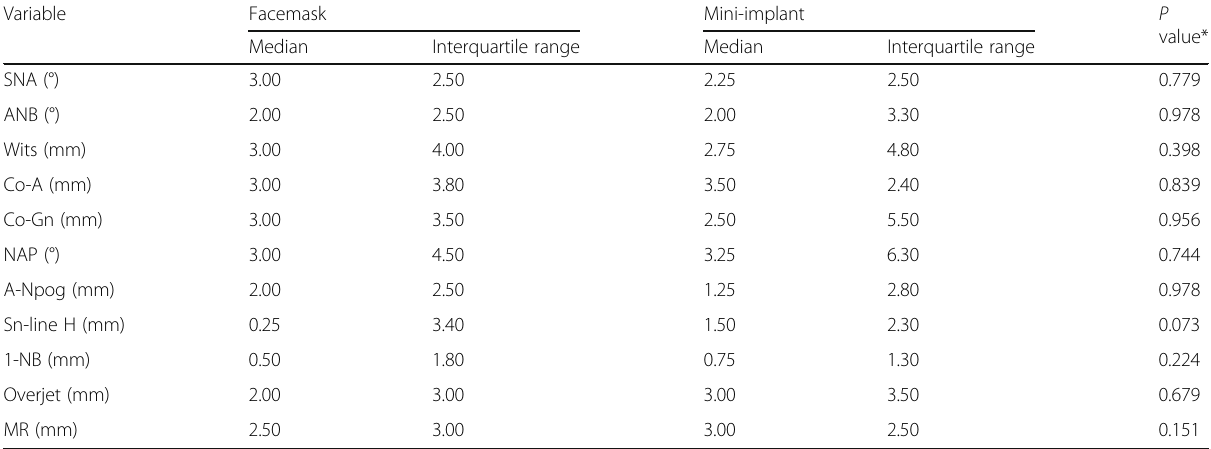
Table 4 Intergroup comparisons of the changes (T0 – T1) in facial characteristics Variable